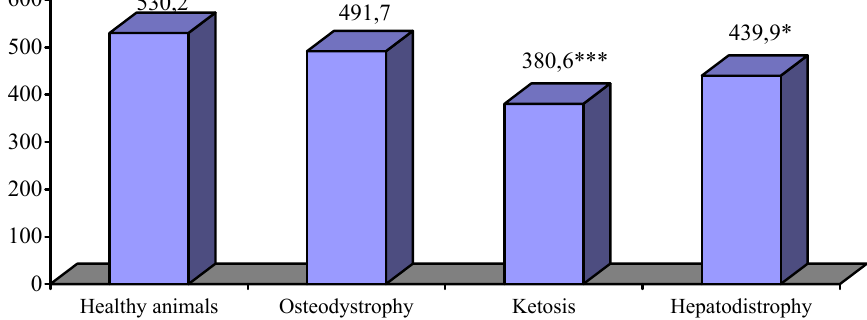
Fig. 2. Content of IFI-1 in blood plasma of cows (mmol/l)